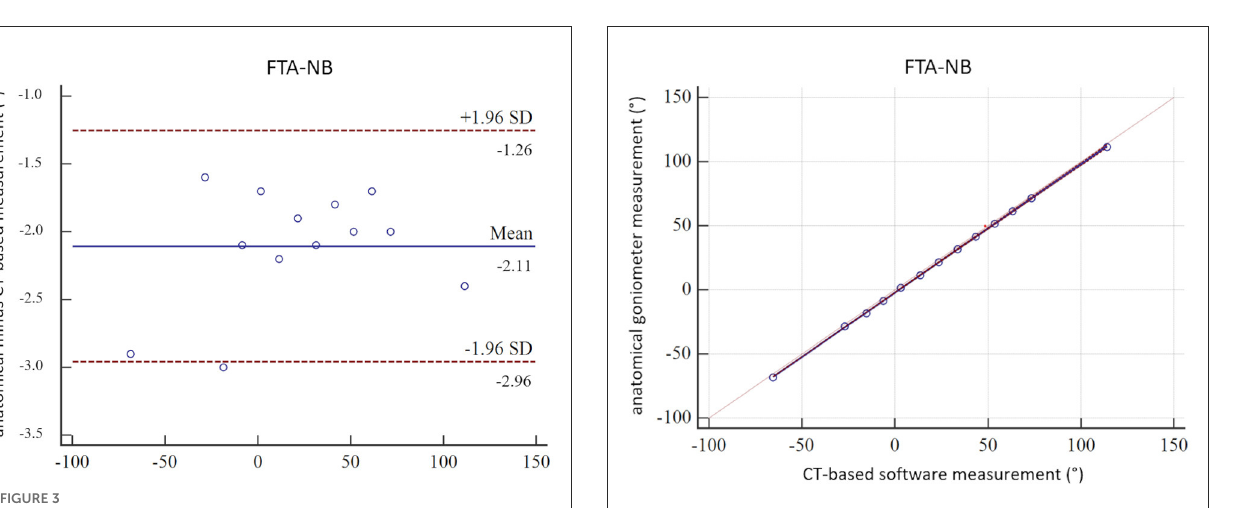
FIGURE4 Passing–Bablok analysis. Scatter plot and regression line of the Passing–Bablok analysis of the comparison between manual anatomical (goniometer) and CT-based (software) femoral neck version (torsion) angle measurements (FTA-NB) in a canine femoral diaphyseal torsional deformity model in 13 preset femoral torsion